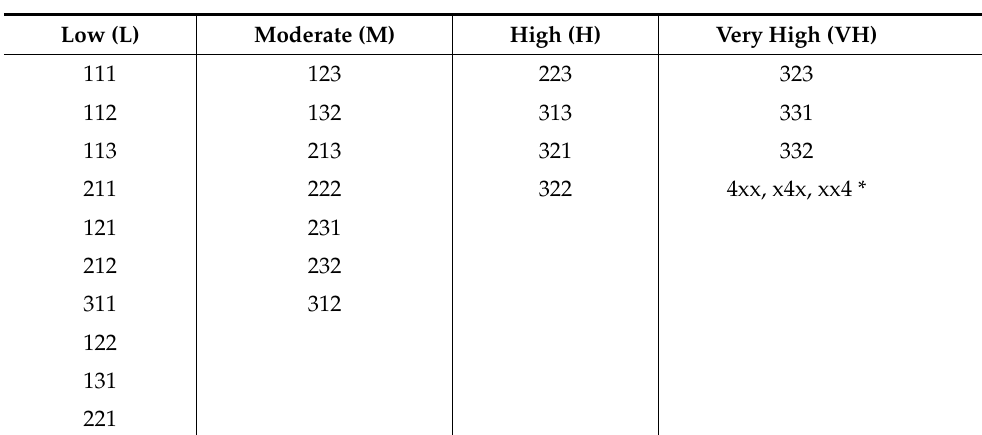
Table 2. Scores for priority